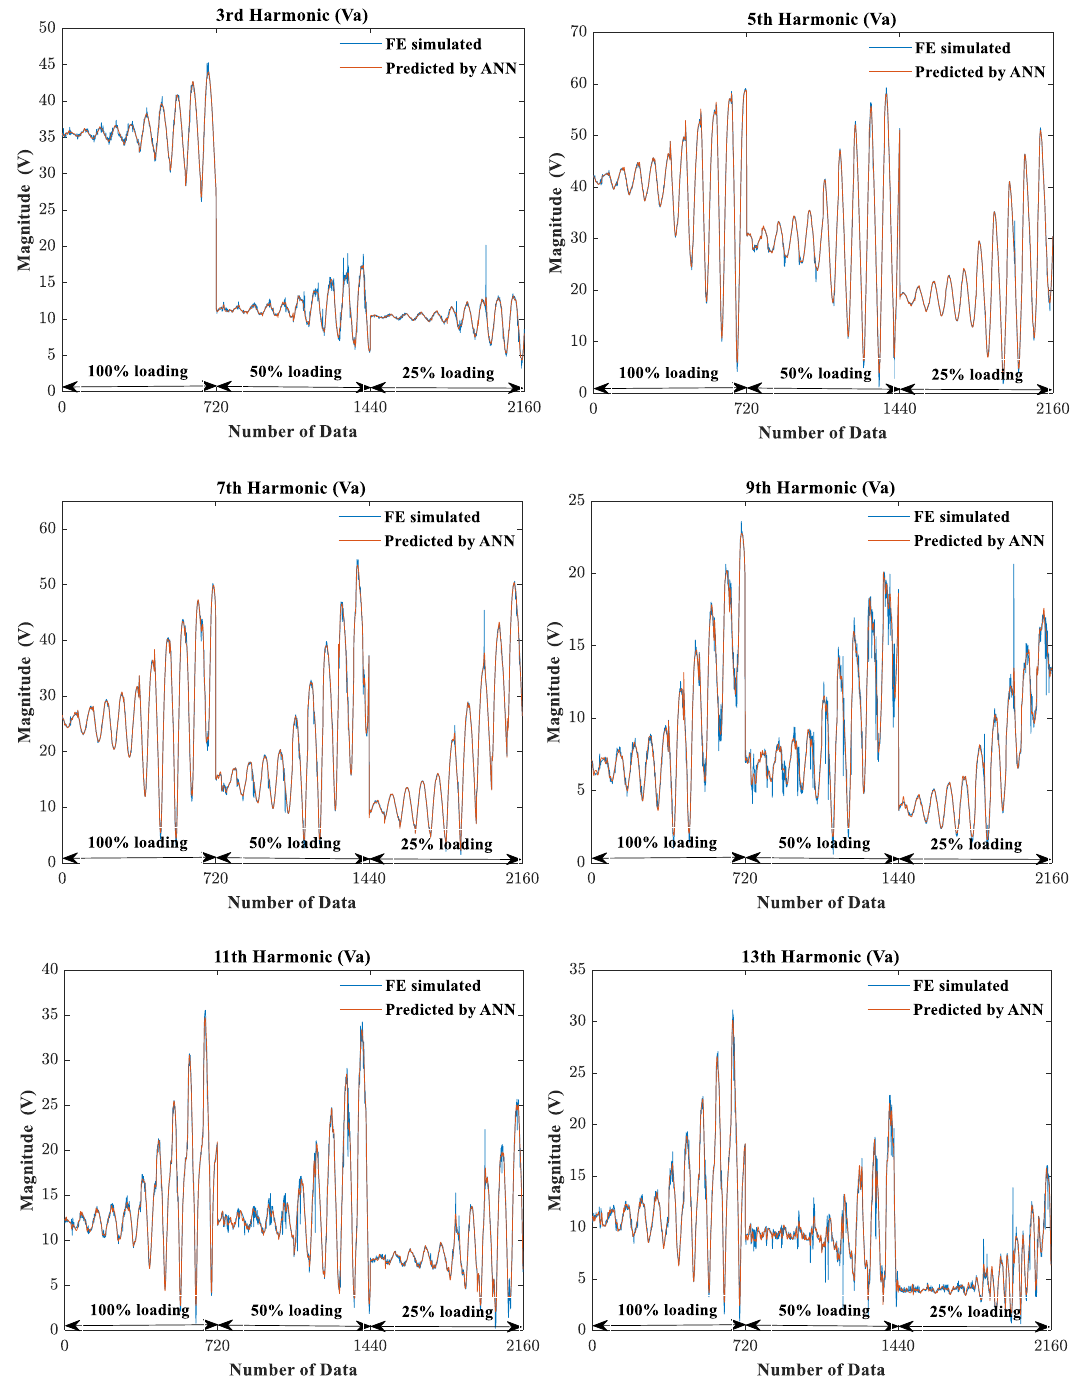
Figure 8. Magnitudes of the non-fundamental harmonic phase voltages simulated by FE and pre- dicted by the developed ANN model.